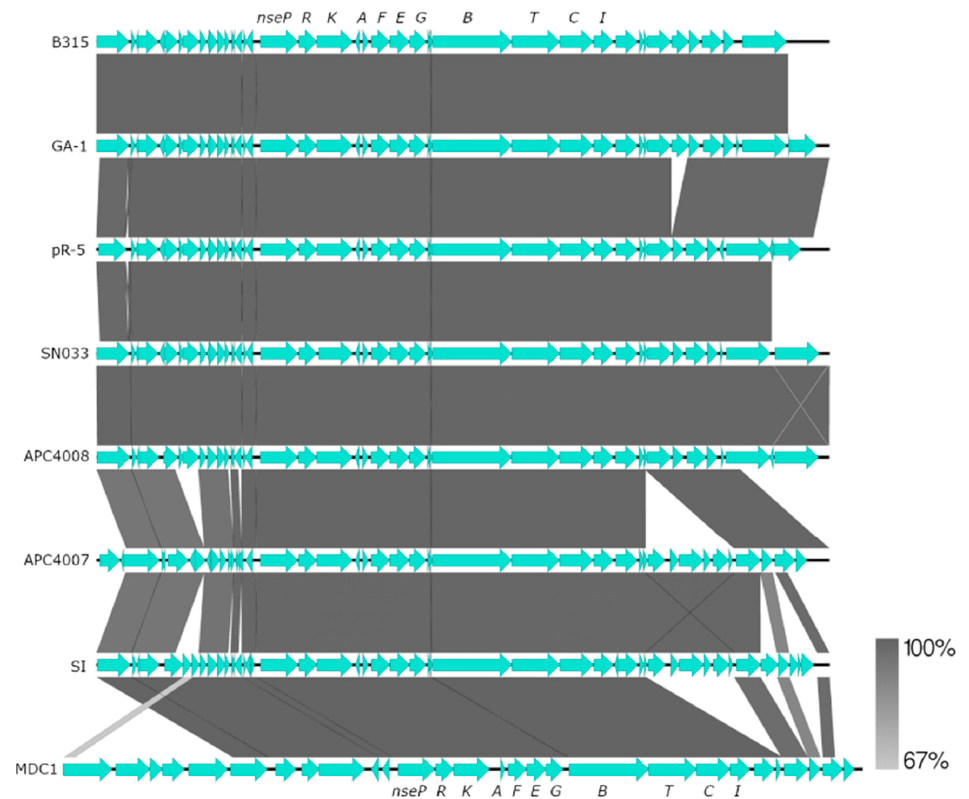
Figure 6. Multiple comparison of nisin E gene cluster ( nsePRKAFEGBTCI ) and its neighbouring genes detected in Streptococcus equinus genomes. Scale represents nucleotide identity.